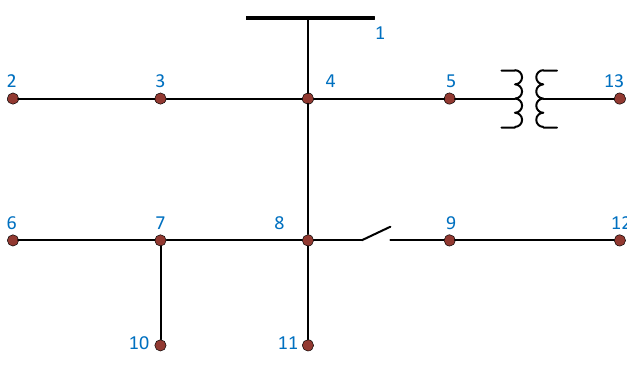
Figure 6. IEEE 13-node test feeder.